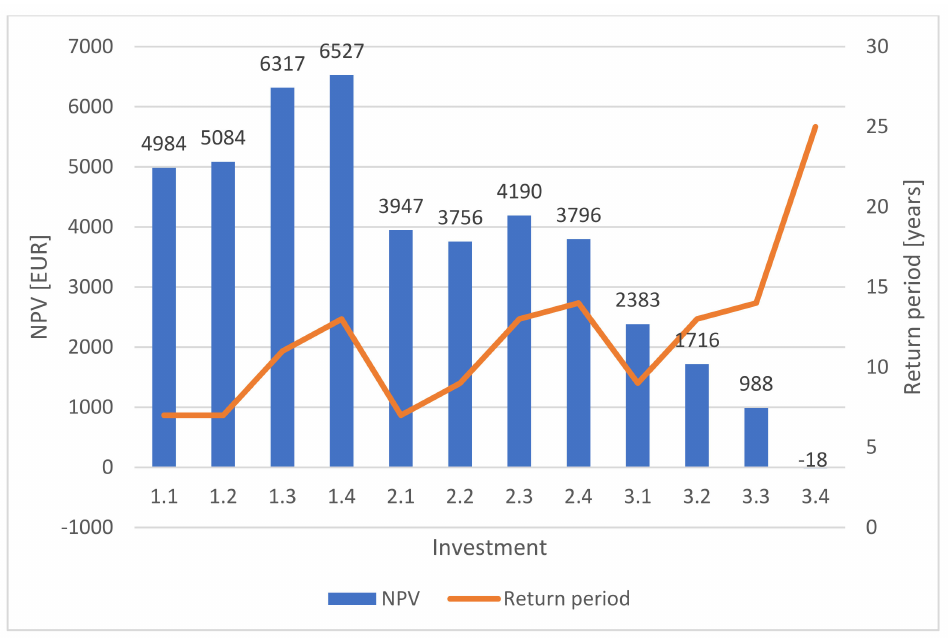
Figure 1. The profitability of analysed investment options. Source: own